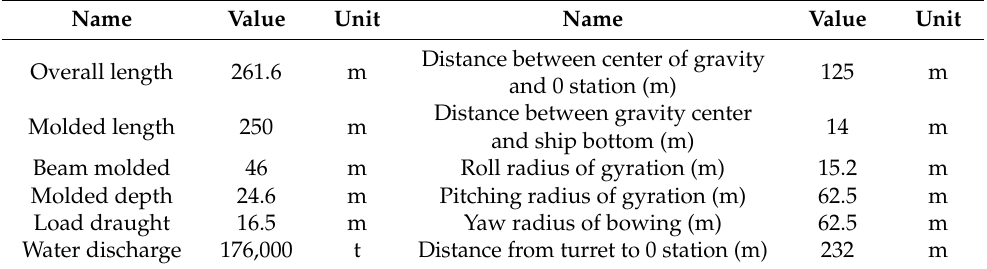
Table 1. Ship’s main dimensions.